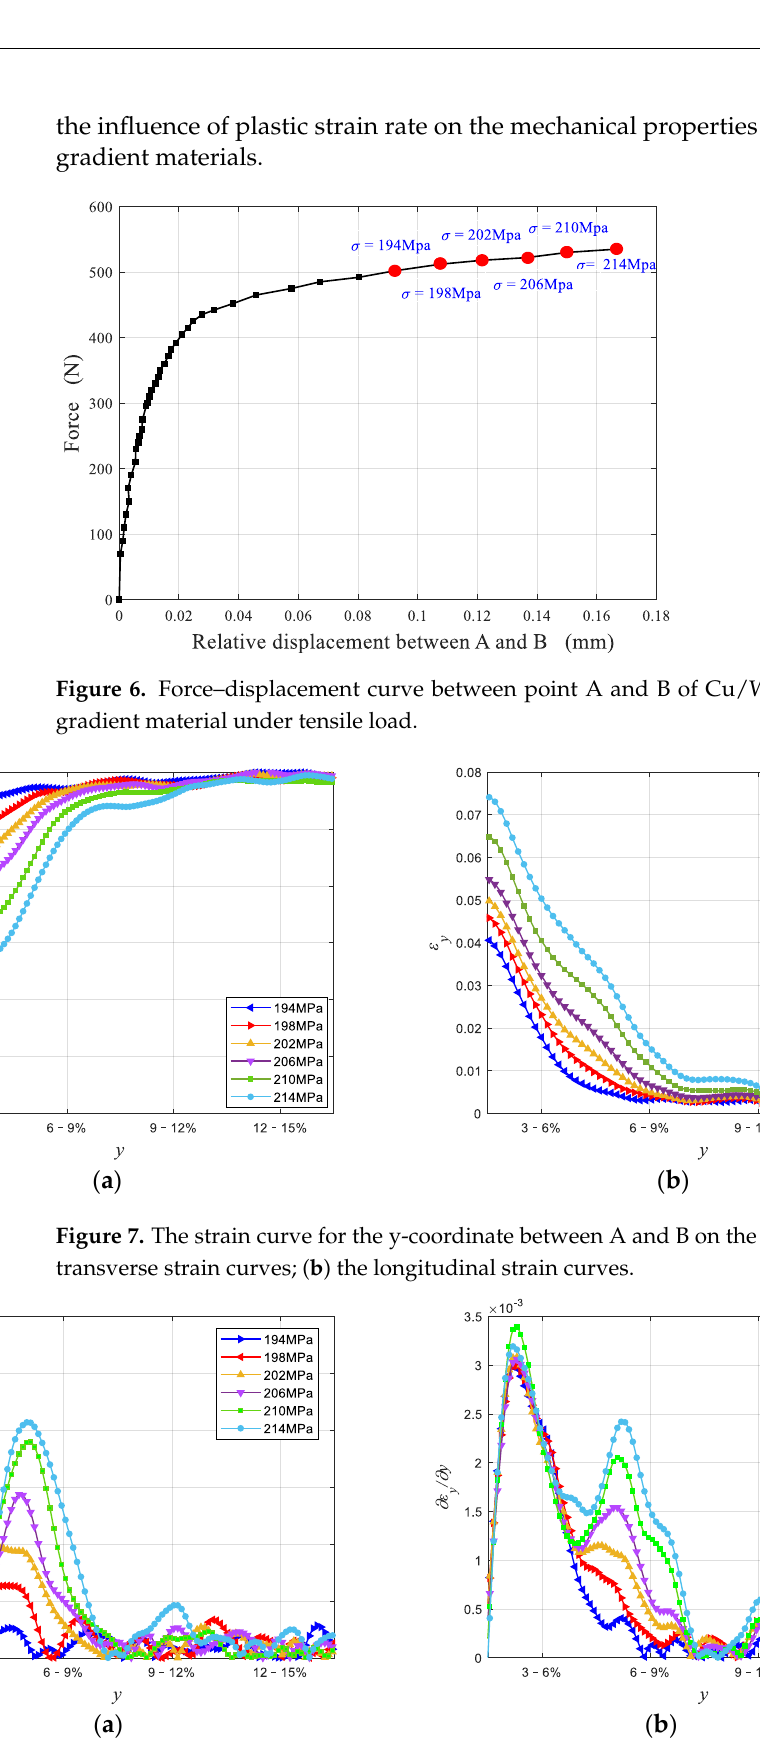
Figure 8. The strain rate curve for the y-coordinate between A and B on the axis of the specimen: ( a ) the transverse strain rate curves; ( b ) the longitudinal strain rate curves.